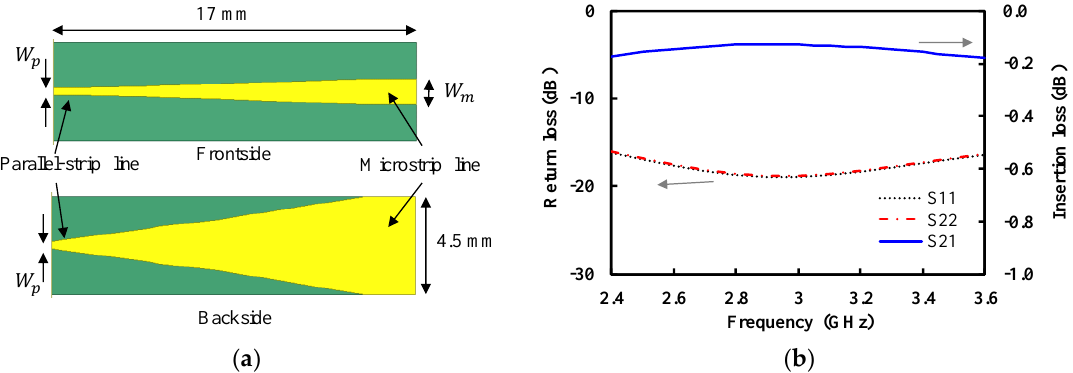
Figure 3. The designed impedance-transforming balun ( a ) layout; ( b ) simulated performance.